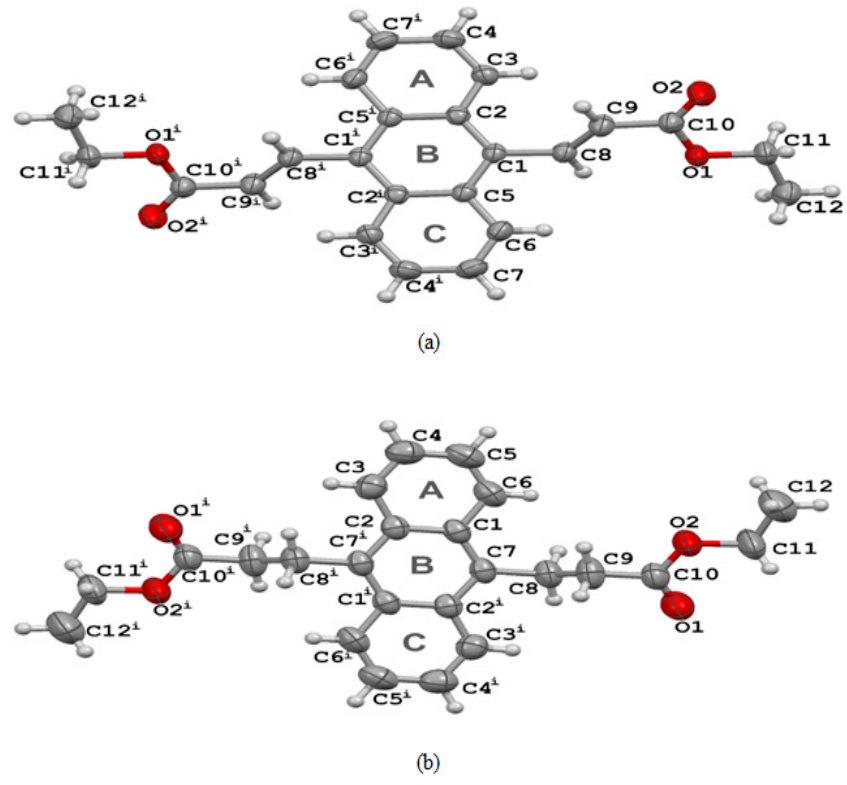
Figure 5. ORTEP view of DADB ( a ) and DEADP ( b ) with atom displacement ellipsoids drawn at 50% probability level. Table 1. Crystal data and structure refinement for DADB and DEADP.